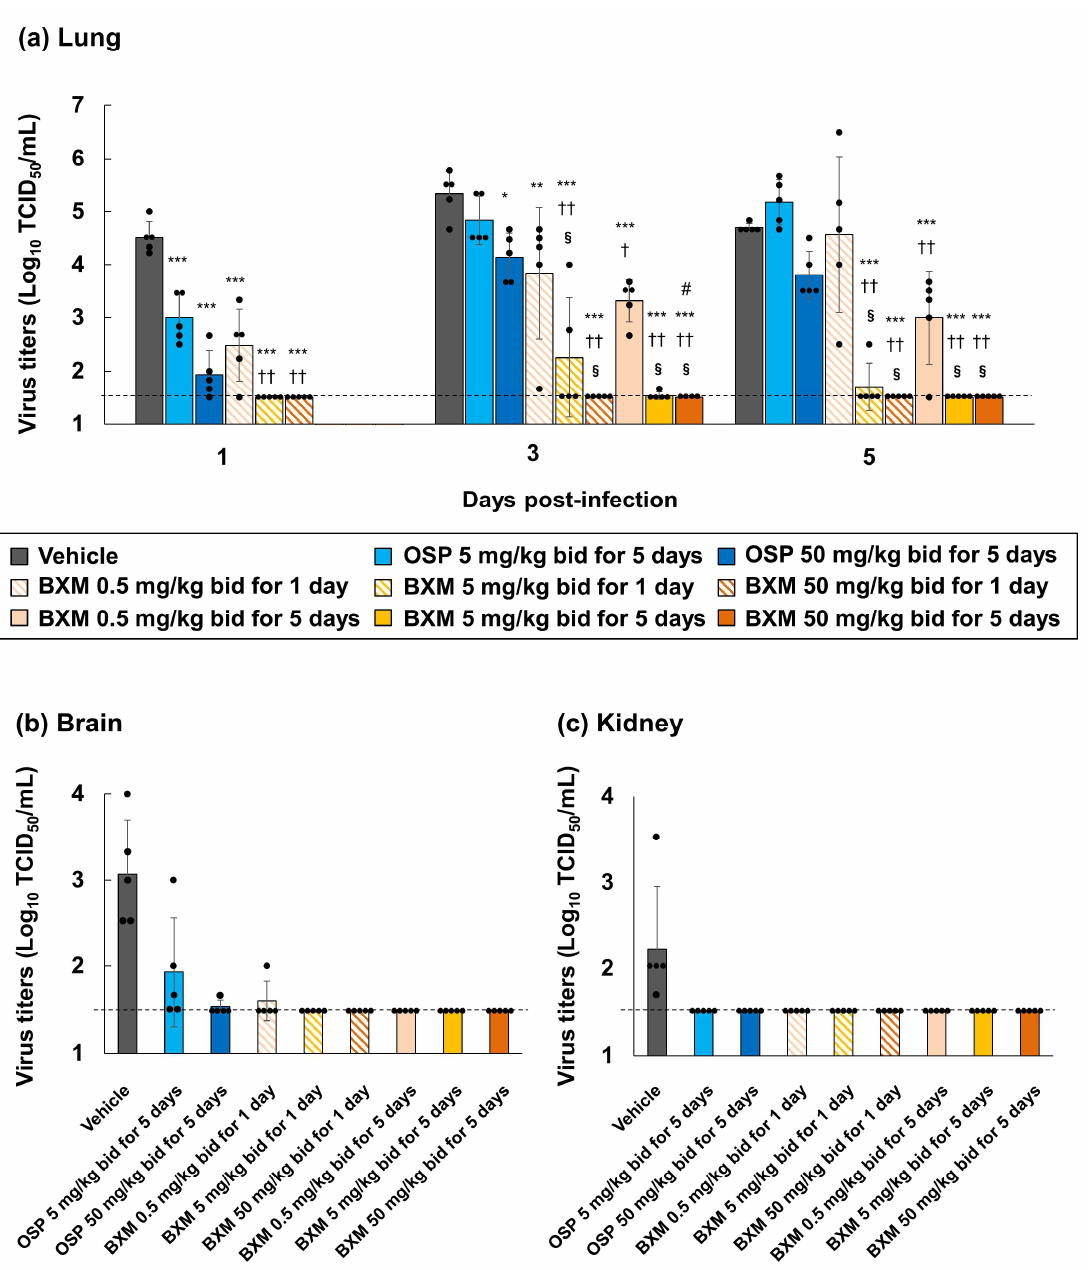
Figure 2. Inhibitory effects of BXM on viral titers in the lungs, brains, or kidneys of mice in- fected with the H5N1 virus. The mice were inoculated with 75 TCID 50 /mouse (31.3 MLD 50 ) of the A/Hong Kong/483/1997 (H5N1) virus, and treatment was started immediately after viral inoc- ulation ( n = 5/group). ( a ) The viral titers (TCID 50 ) in mice lungs at 1, 3, and 5 days post infection (dpi) measured in Madin–Darby canine kidney (MDCK) cells. ( b , c ) The viral titers in mice